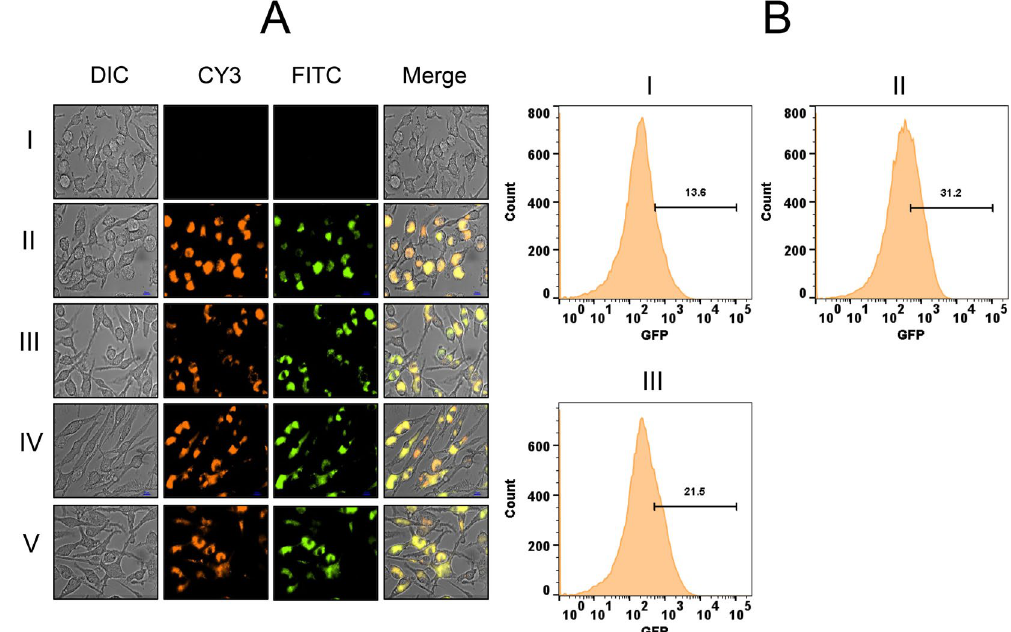
Figure 5. Induction of GFP in M . smegmatis MSOHG4 strain by intracellular organic hydroperoxides of macrophages. ( A ) GFP expression assessed by microscopy. BMDM cells grown on glass coverslips were infected with M . smegmatis MSOHG4 bearing ohrR - pohr - gfpuv and phsp60 - rfp fusions for 2, 4, 12 and 24 h at 37 °C. After washing, the coverslips were examined under Nikon TiE Inverted Fluorescence Microscope using 60X objective. DIC, Cy3 and FITC indicate images obtained using these filters. ‘Merge’ indicates the merged images of DIC, CY3 and FITC. I, Images of uninfected BMDM, and II–V, images of BMDM infected with MSOHG4 for 2, 4, 12 and 24 h of infection, respectively. ( B ) GFP expression assessed by flow cytometry. BMDM cells grown on culture dishes were infected with M . smegmatis wild type (I), MSOHG2 (II) and MSOHG3 (III) for 4 h at 37 °C. After washing, cells were processed for flow cytometry. Flow analysis was performed in BD FACSAriaII using excitation and emission wavelengths of 395 nm and 509 nm,